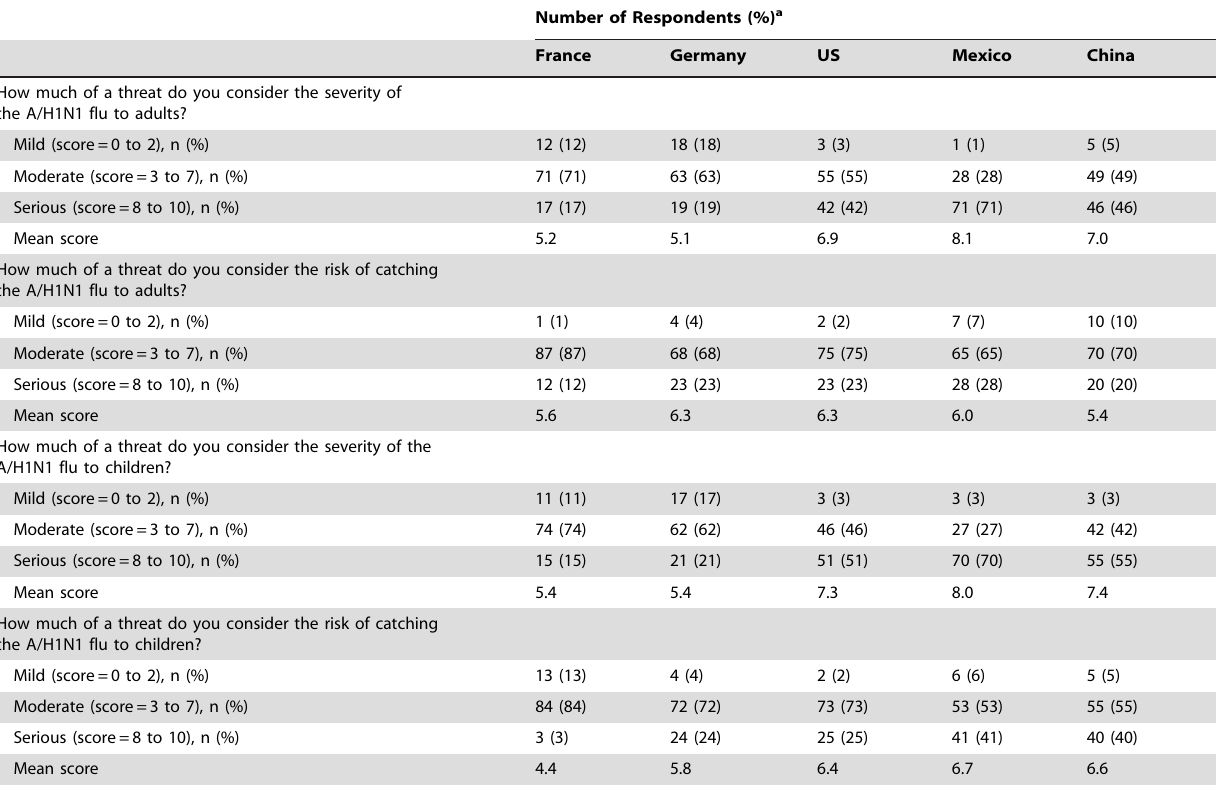
Table 4. GP opinions about A/H1N1 pandemic